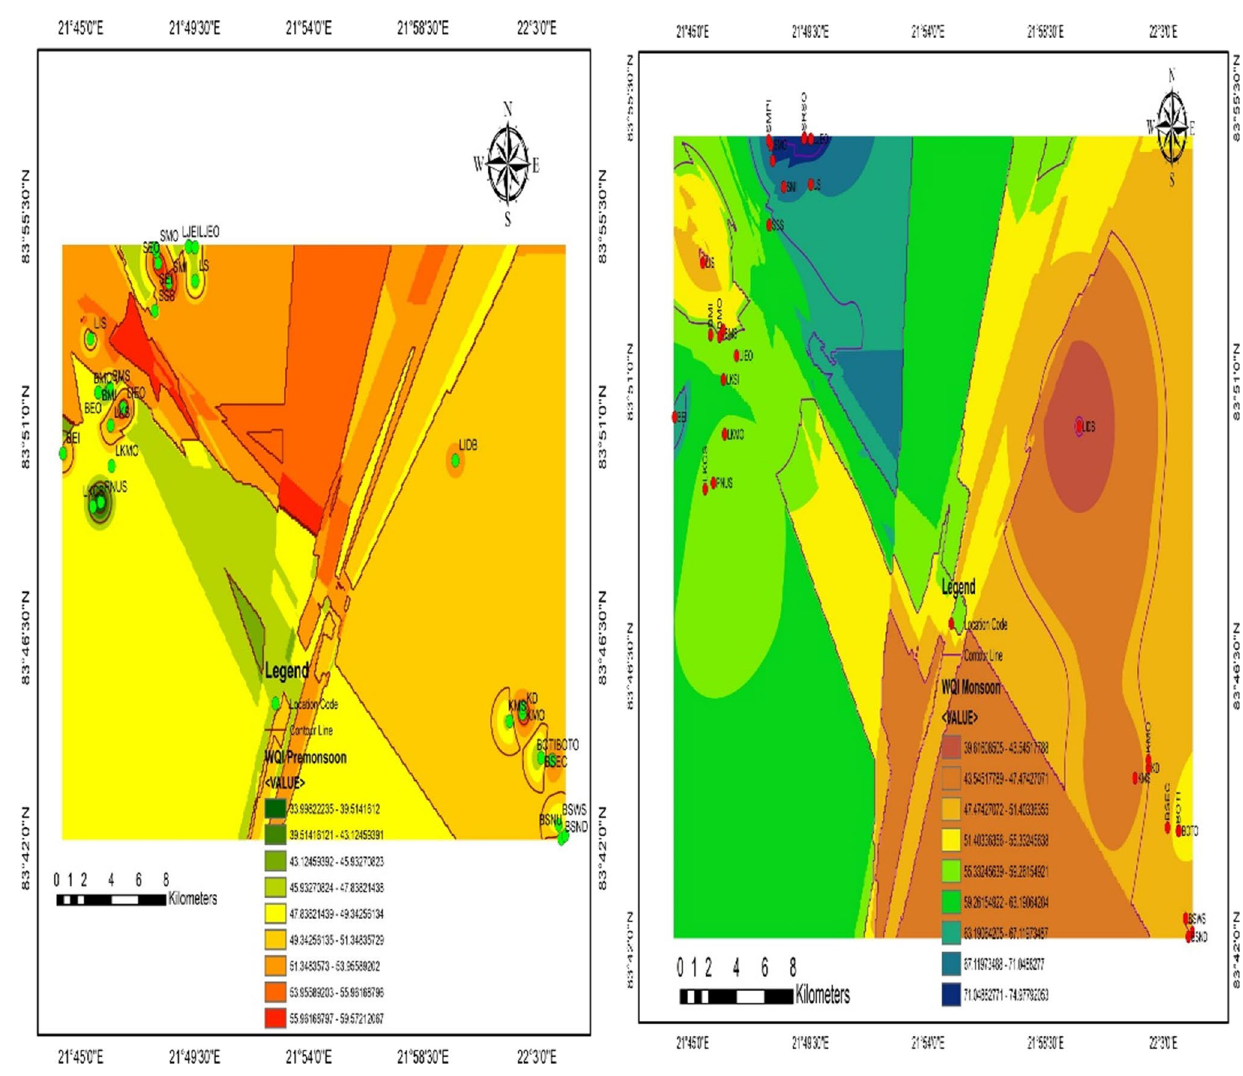
Fig. 13 Contour map of WQI in water samples during premonsoon and monsoon